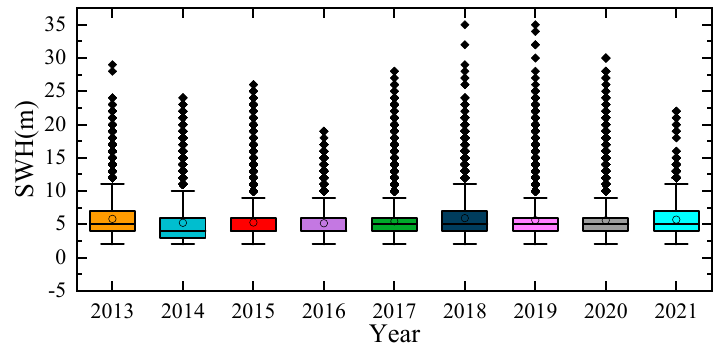
Figure 7. Box plot of SWH effective data for calendar year.